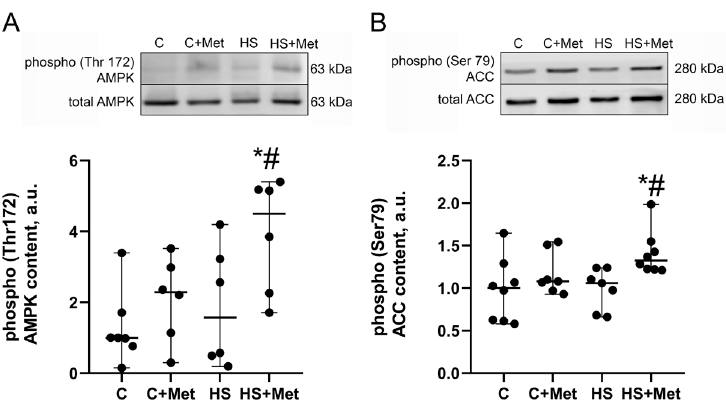
Figure 3. Effect of metformin pre-treatment on AMP-activated protein kinase (AMPK) (Thr172) phosphorylation ( A ) and acetyl-CoA carboxylase (ACC) (Ser79) phosphorylation ( B ) in rat soleus muscle. C, vivarium control, C+Met, vivarium control + metformin pre-treatment, HS, 7-day hindlimb suspension, HS+Met, metformin pre-treatment + 7-day hindlimb suspension. Scatter dot plots indicate median values, and the whiskers represent minimum and maximum values; n = 6–8/group. *: p < 0.05 vs. C, #: p < 0.05 vs. HS.